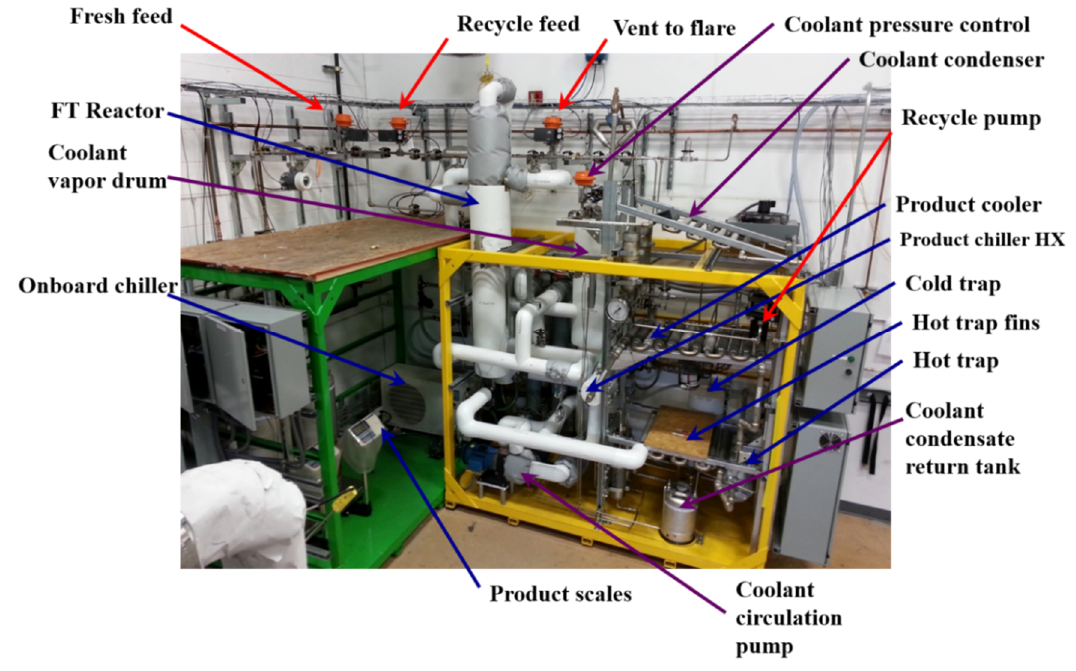
Figure 3. The OxEon Energy commercial-scale fixed-bed reactor prototype and skid that supports the reactor assembly.